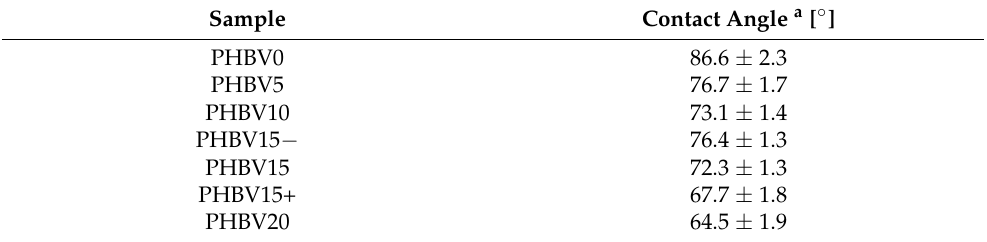
Table 5. Water contact angles of PHBV film modified with LiBH 4 under different